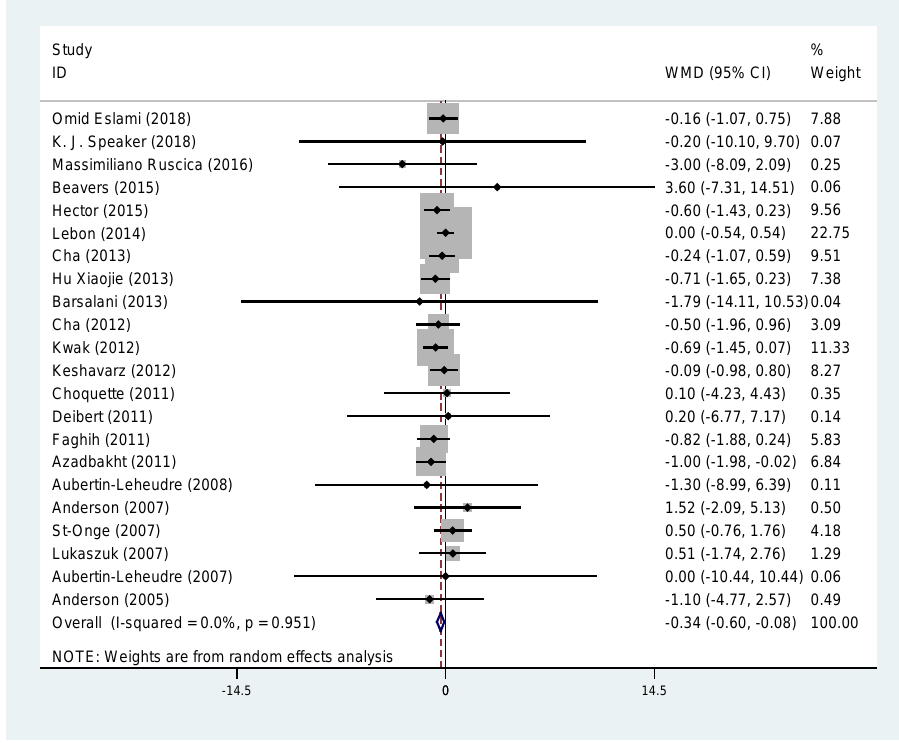
Figure 2. Meta-analysis of the effect of soy products on body weight. ID: identification; WMD: weighted mean difference.